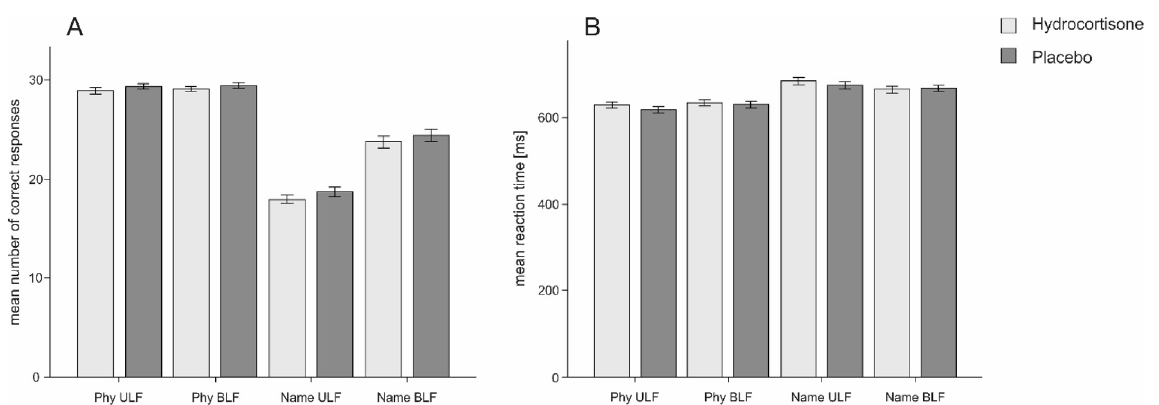
Figure 3. Mean number of correct responses ( A ) and mean reaction times ( B ) for each condition and visual field in the Banich–Belger task. Error bars represent ± 1 SEM. Physical and name matching conditions and unilateral and bilateral field are